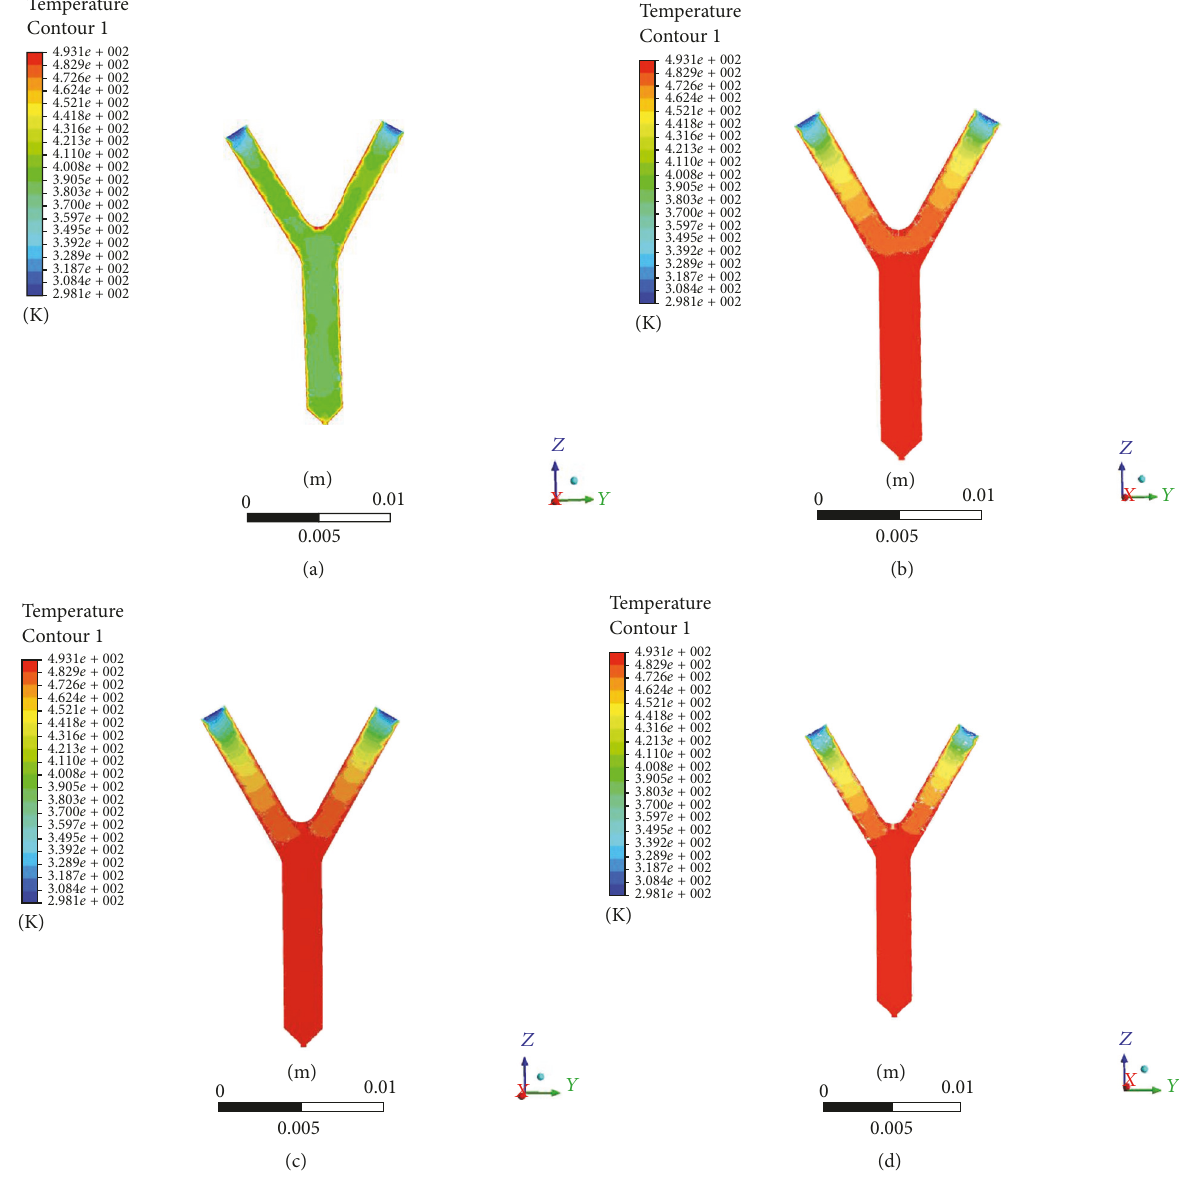
Figure 6: Temperature contours of the flow channel at the temperature of 493.15 K: (a) at the time of 5 s; (b) at the time of 30 s; (c) at the time of 50 s; (d) at the time of 60